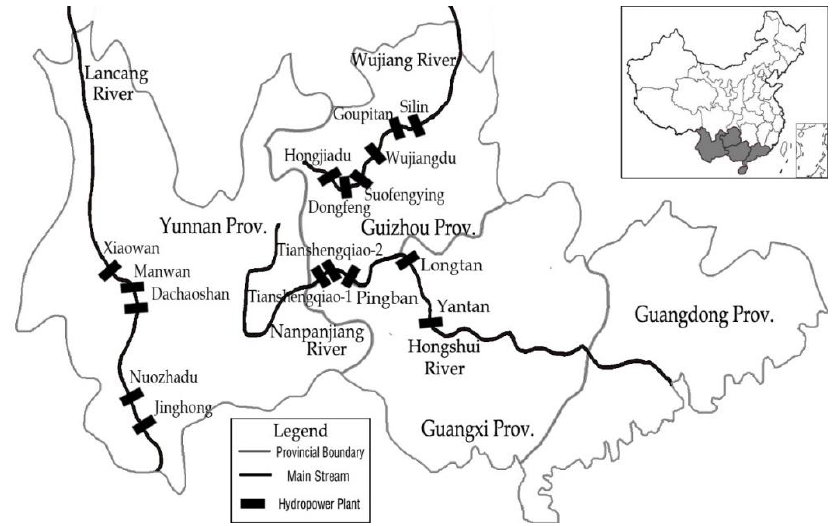
Figure 3. The studied hydropower system. Table 1. Characteristics of the studied hydropower system.